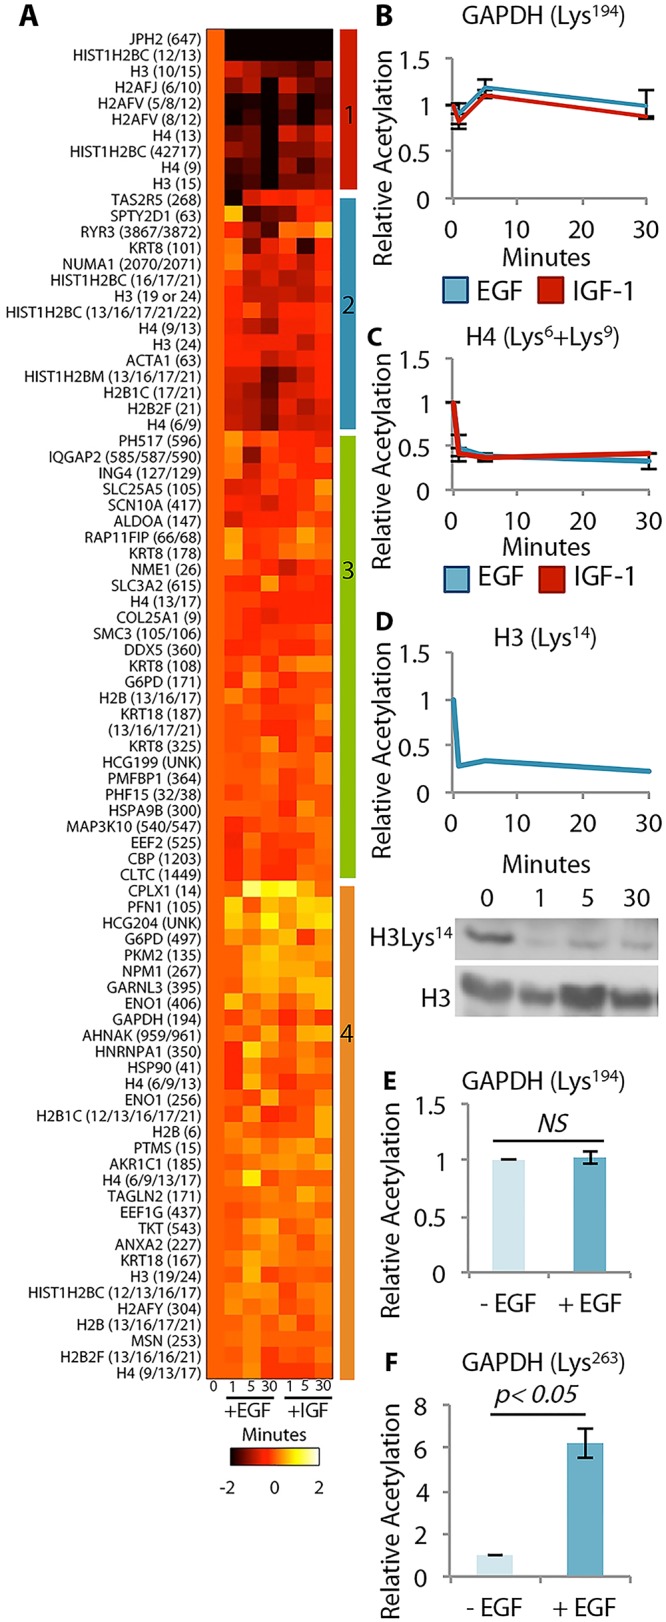
Quantitative acetyllysine profiling of A549 cells stimulated with EGF or IGF-1.
A. Heat map of log2 fold-change relative to the unstimulated condition of the 90 acetylation sites quantified. Colored bars at the right indicate the clusters. B. Comparison of acetylation dynamics on GAPDH. C. Comparison of acetylation dynamics on histone H4, Lys6 and Lys9. D. EGF-stimulated Histone H3 Lys14 acetylation dynamics analyzed by mass spectrometry and western blotting. E. Acetylation dynamics quantified by SILAC on GAPDH Lys194. F. Acetylation dynamics quantified by SILAC on GAPDH Lys263.